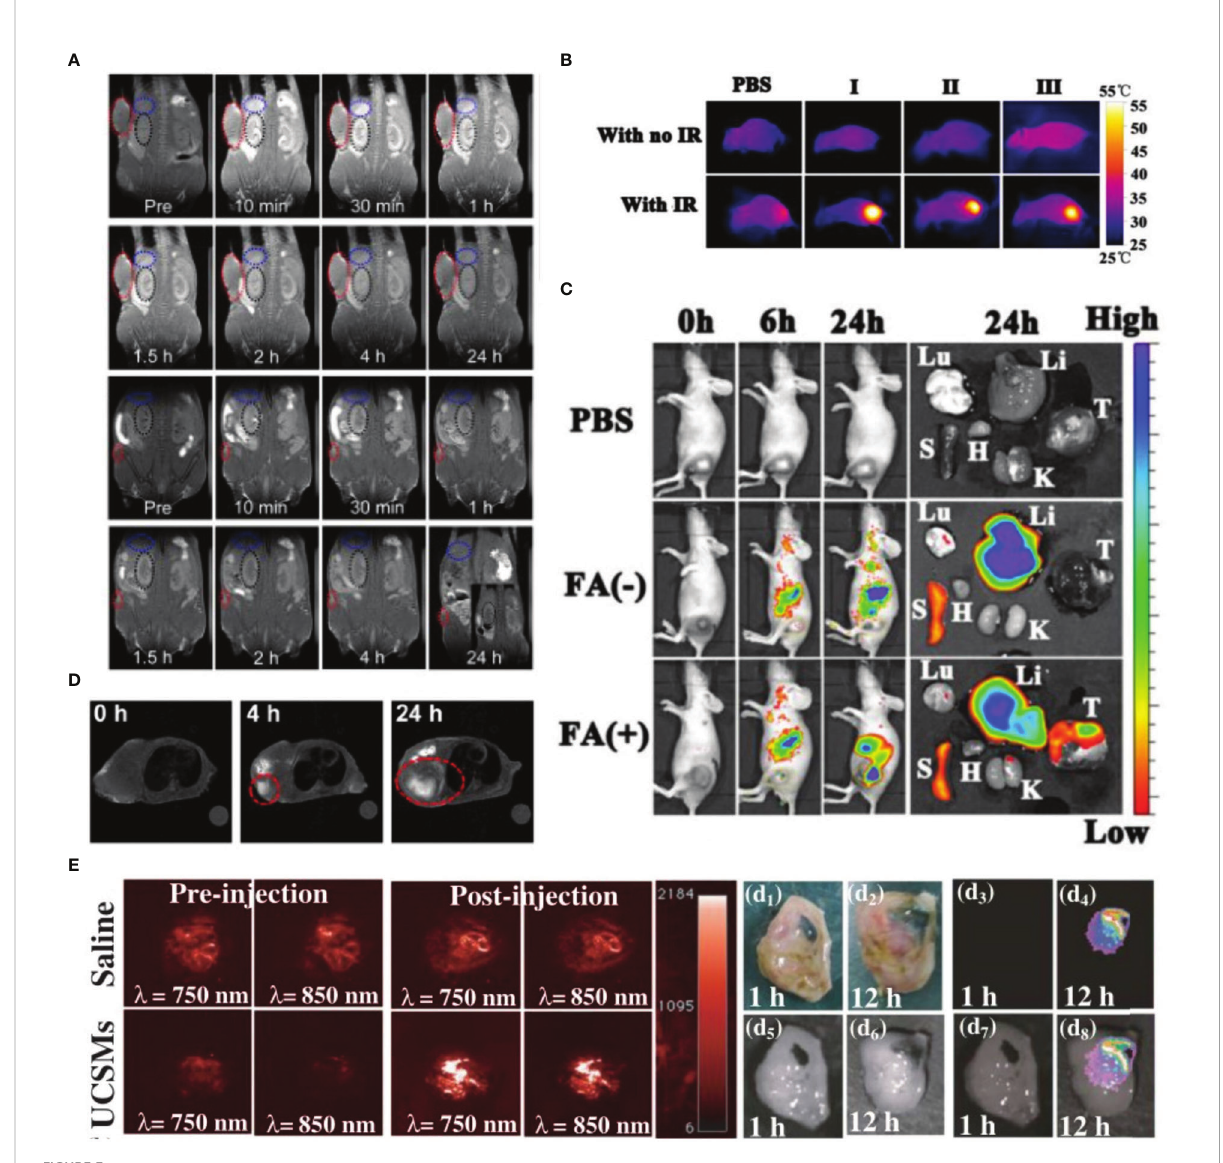
FIGURE 3 Variety of metal nanoparticles have great imaging effect. (A) In vivo MRI images of the Fe 2 O 3 SPs, the tumor sizes are about 300 and 5 mm 3 , respectively. Reprinted with permission (83). Copyright 2020 ACS Nano. (B, C) Reprinted with permission (84). Copyright 2021 Biomaterials. (B) The photothermal images of tumor-bearing mice with injection of Hb-PDA-Fe@GOD@PEG-FA after being exposed to 808 nm irradiation. (C) In vivo biodistribution of Hb-PDA-Fe@GOD@PEG-FA nanoparticles. (D) In vivo MRI of tumor-bearing mice before and after intravenous injection of mCMSNs. Reprinted with permission (82). Copyright 2019 ACS Nano. (E) Representative 2D photoacoustic images of solid tumors before and after injection of saline/MnO 2 -UCSMs. Reprinted with permission (81). Copyright 2015 Advanced